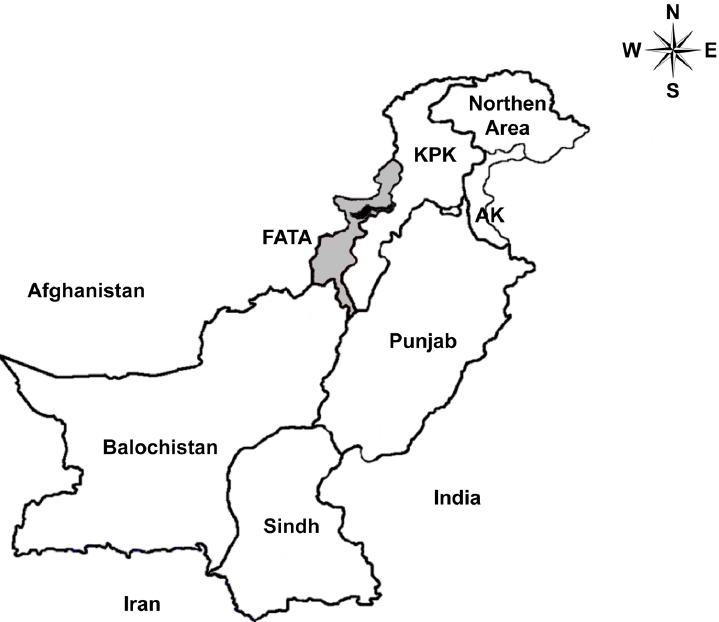
Fig 1. Geographical location of sample collection site (Orakzai Agency: black area) in FATA, Pakistan. FATA (gray): Federally Administered Tribal Areas, KPK: Khyber Pakhtunkhwa, AK: Azad Kashmir.